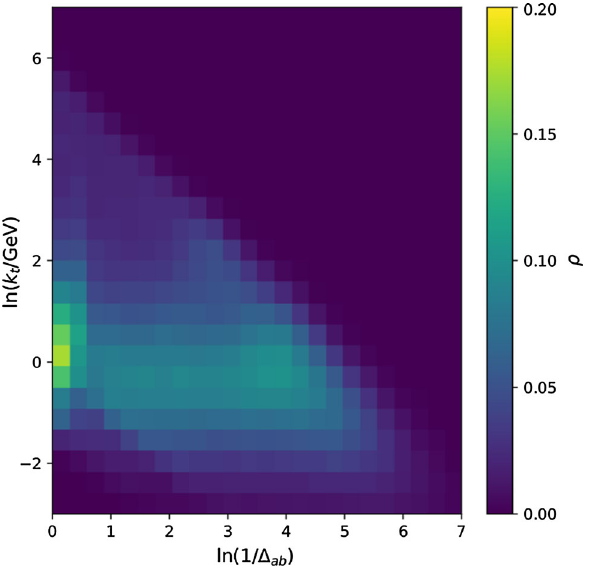
Fig. 1 Average Lund jet plane density for QCD jets simulated with Pythia v8.223 and Delphes